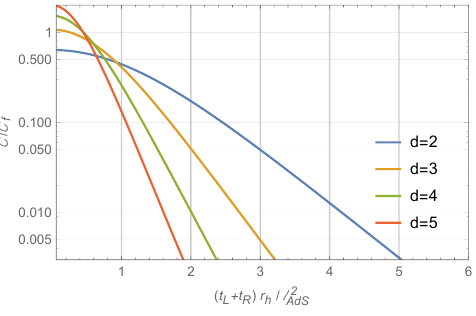
Figure 6 . The values of (cid:127) C for d = 2 ; 3 ; 4 ; 5. _ C f is the Lloyd’s bound of growth rate, which is given by eq. (3.58). We can see that (cid:127) C > 0 and so _ C f is the maximum value of _ C . Numerical results show that this is the maximum value of the growth rate at all time (see (cid:12)gure 6), which is di(cid:11)erent from the CA